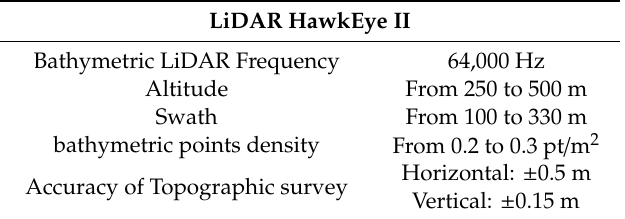
Table 1. Main Technical features of bathymetric LiDAR sensor and positioning